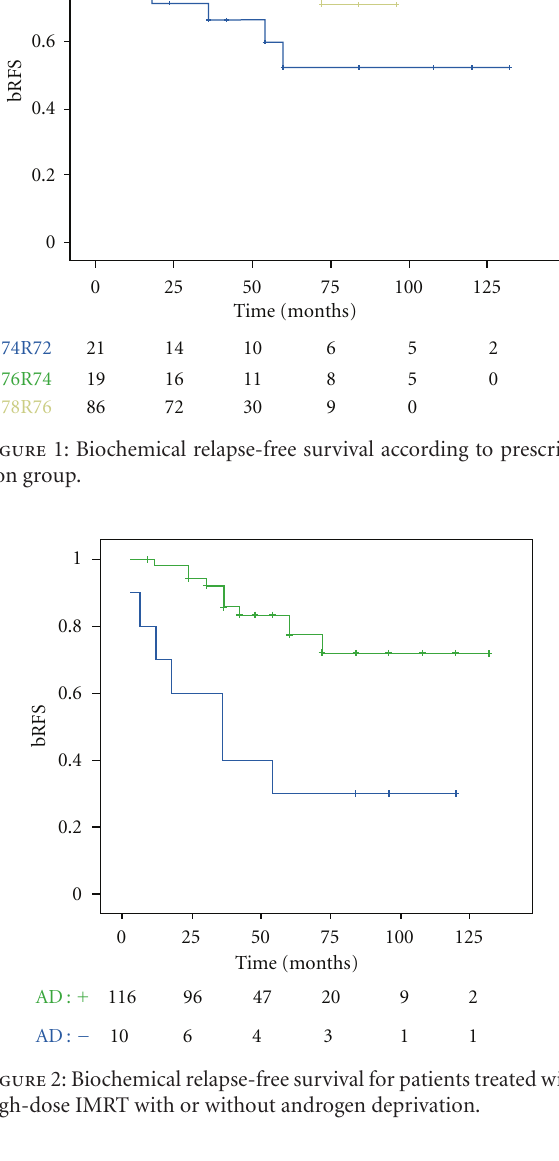
cRFS and dose (67%, 83%, and 90% for 74R72, 76R74, and 78R76, resp.; P = 0 . 04) as well as between 5-year cRFS and AD (91% versus 30%; P < 0 .